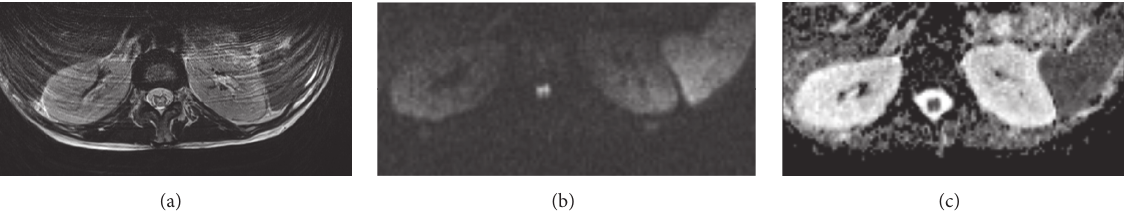
Figure 1: (a) The sagittal T2-weighted image shows a hyperintense lesion of the conus medullaris. (b) High signal is observed at the corresponding level on axial DWI. (c) Low ADC value on the ADC map confirmed the hypothesis of spinal cord